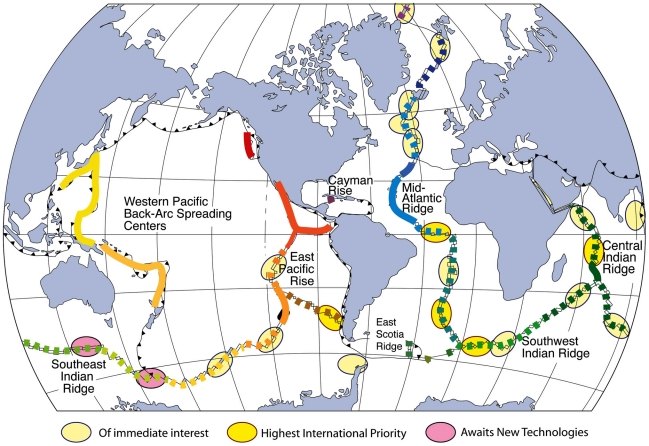
Annotated map (after Van Dover, 2010) of the global ridge crest, illustrating both a model of the global biogeographic differentiation of invertebrate species associated with hydrothermal vents and regions recently identified by the international community as being of continuing importance for future ridge-crest exploration.Ellipses show three categories of importance assigned to twenty three separate locations distributed along the ridge axis (see Table 1); different coloured lines along-axis represent regions that share many of the same species (see Van Dover, 2010).